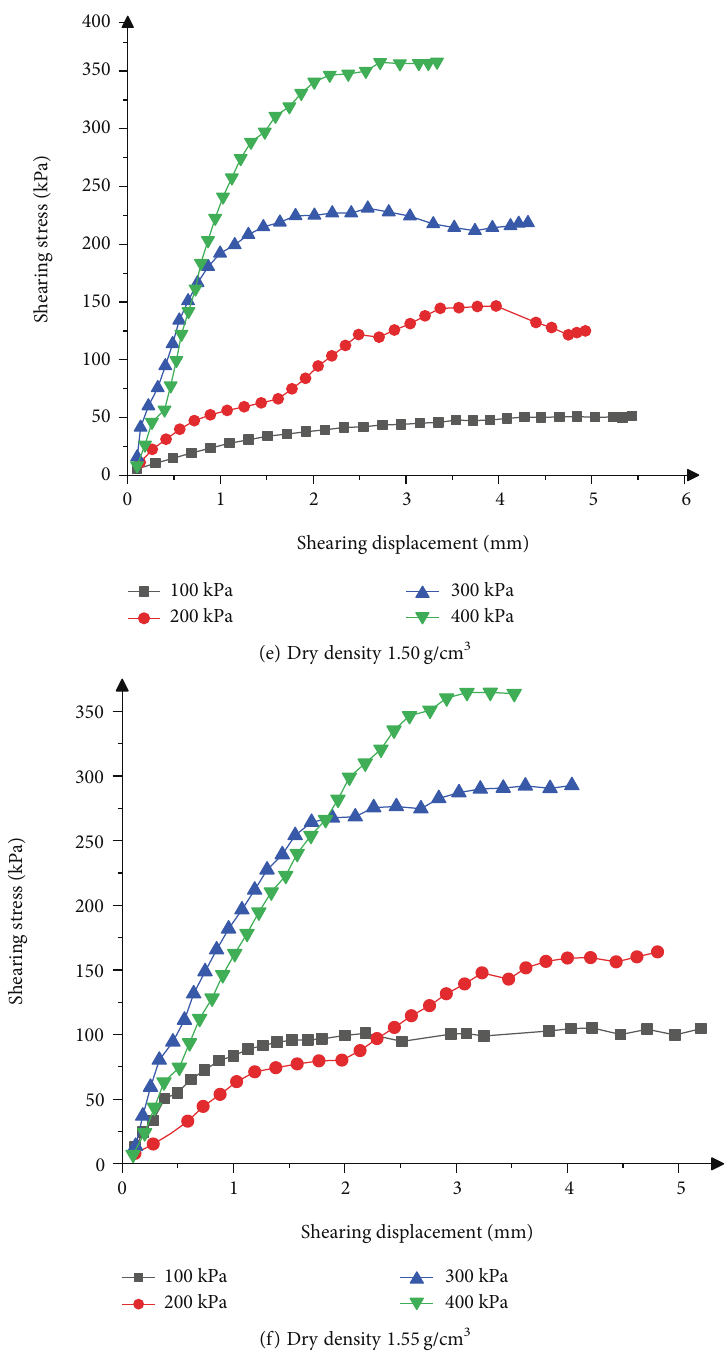
Figure 3: The relationship curve between shear stress and shear displacement in direct shear test.